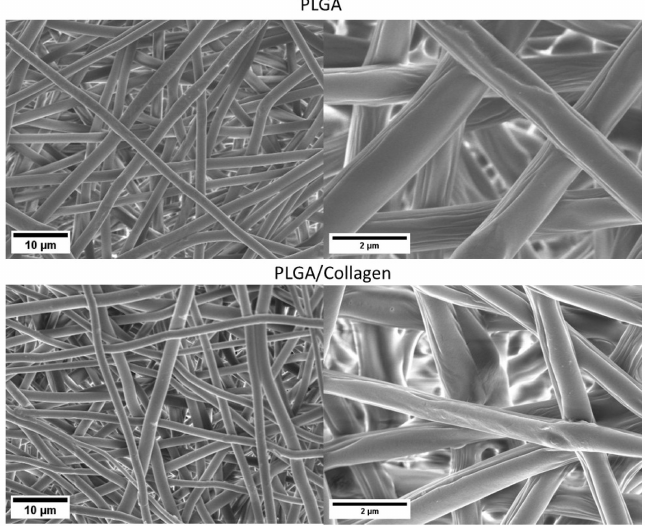
Figure 1. SEM images of PLGA and PLGA/collagen